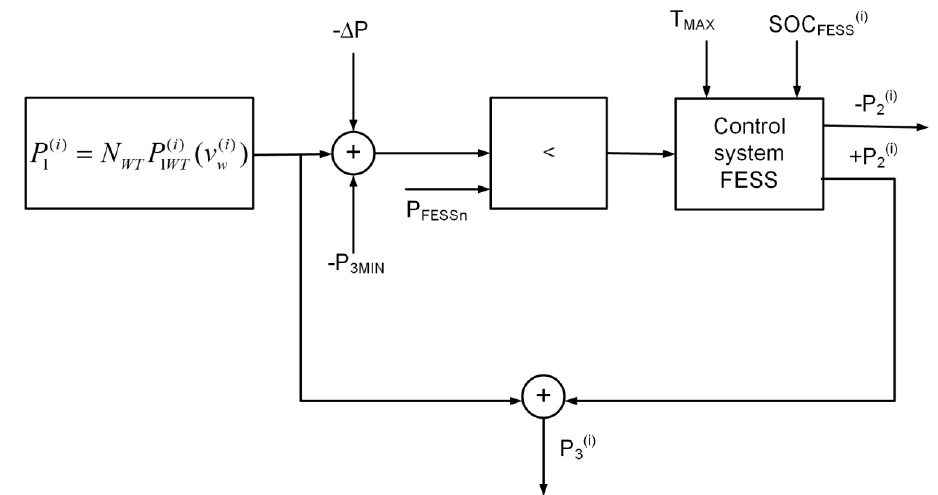
Figure 2. Block diagram of the interface algorithm between the flywheel storage system and the wind power plant.